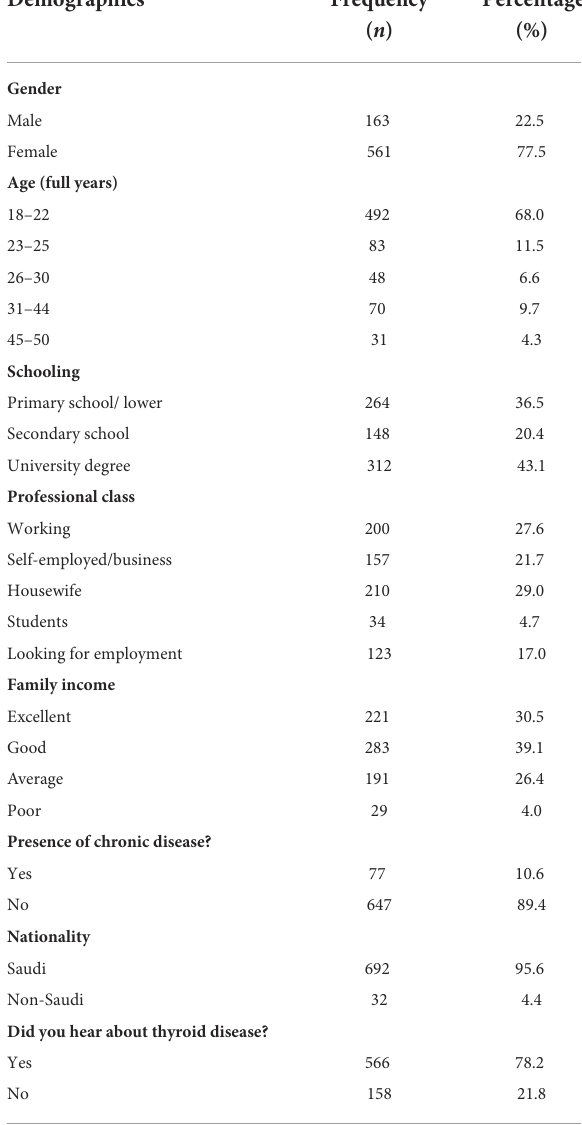
TABLE 1 Socio-demographic characteristics and clinical profile of the study